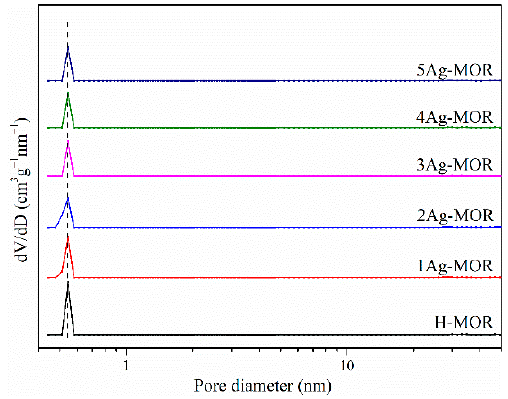
Figure 1. Ar adsorption–desorption isotherms of the catalysts.